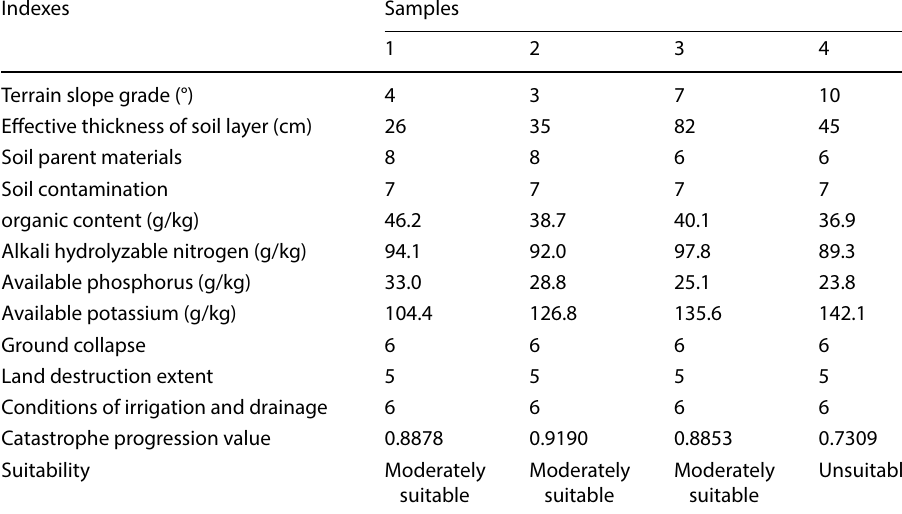
Table 4 Suitability evaluation results of land reclamation as arable land in Shuijingtou working